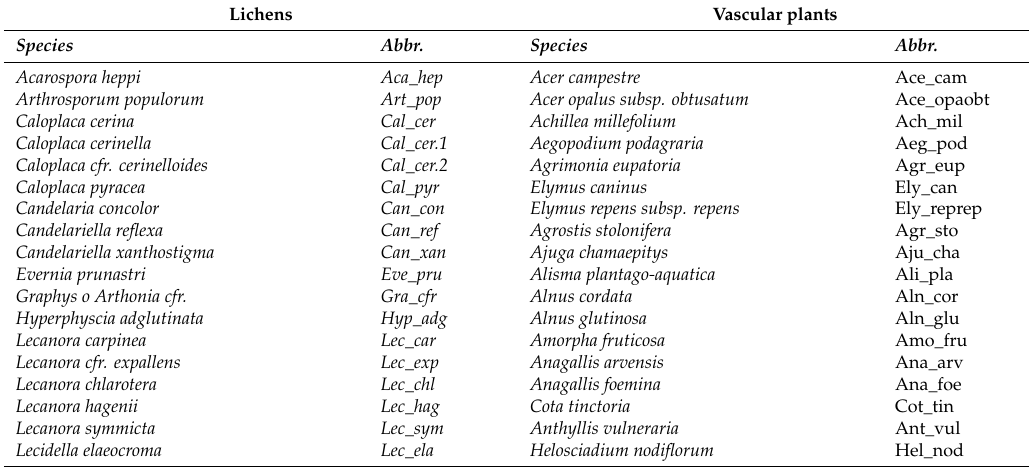
Table A1. Abbreviation list of Lichens and Vascular Plants, as presented in the Co-Correspondence analysis (Fig. IV, Bacaro et al.